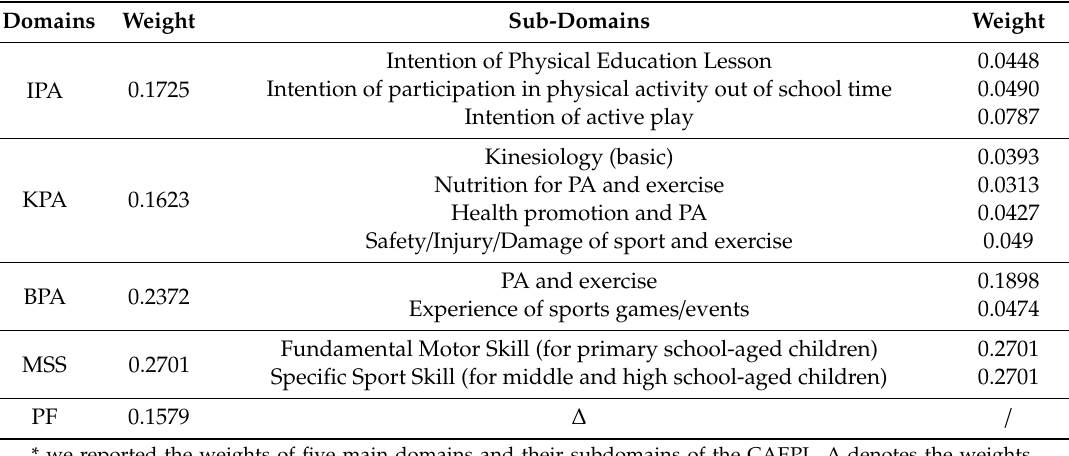
Table 3. Weights of domains and sub-domains of the CAEPL